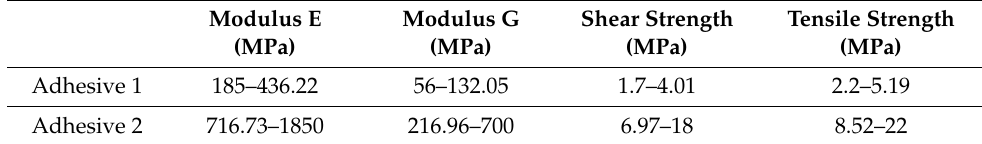
Table 1. Ranges of changes in the parameters of dual adhesive joints.